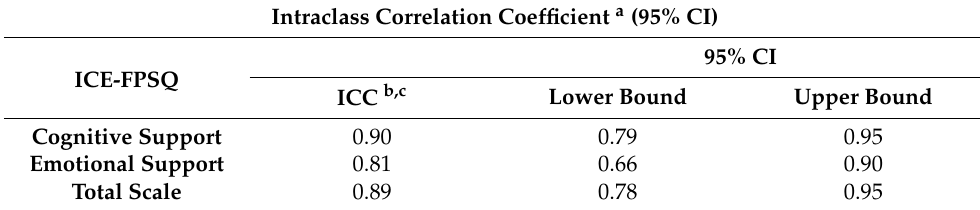
Table 4. Test–retest analysis of the ICE-FPSQ ( n =